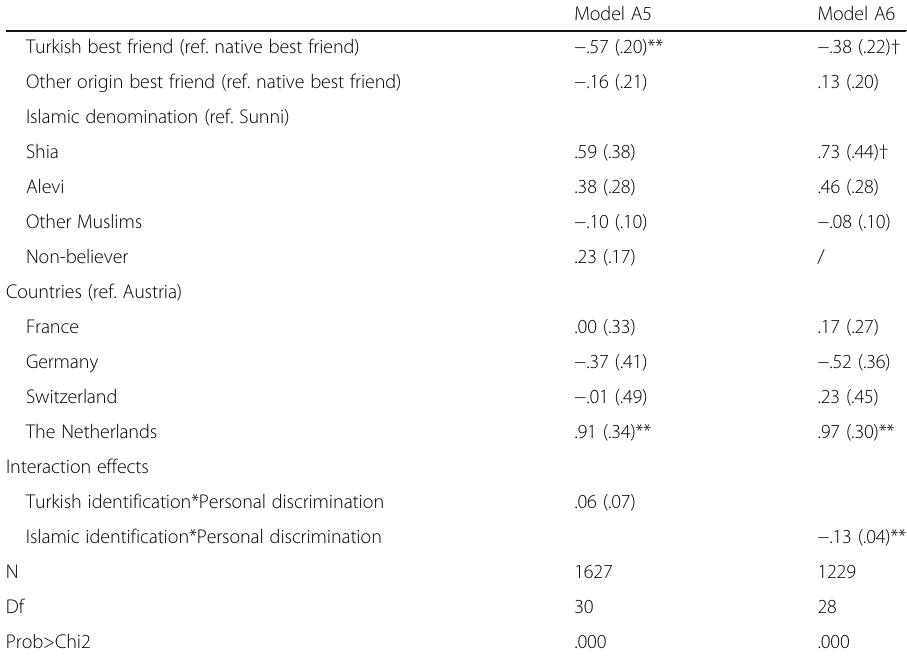
Table 11 Binary logistic regression: Interplay between social identifications, personal discrimination and local voting probability (Continued)